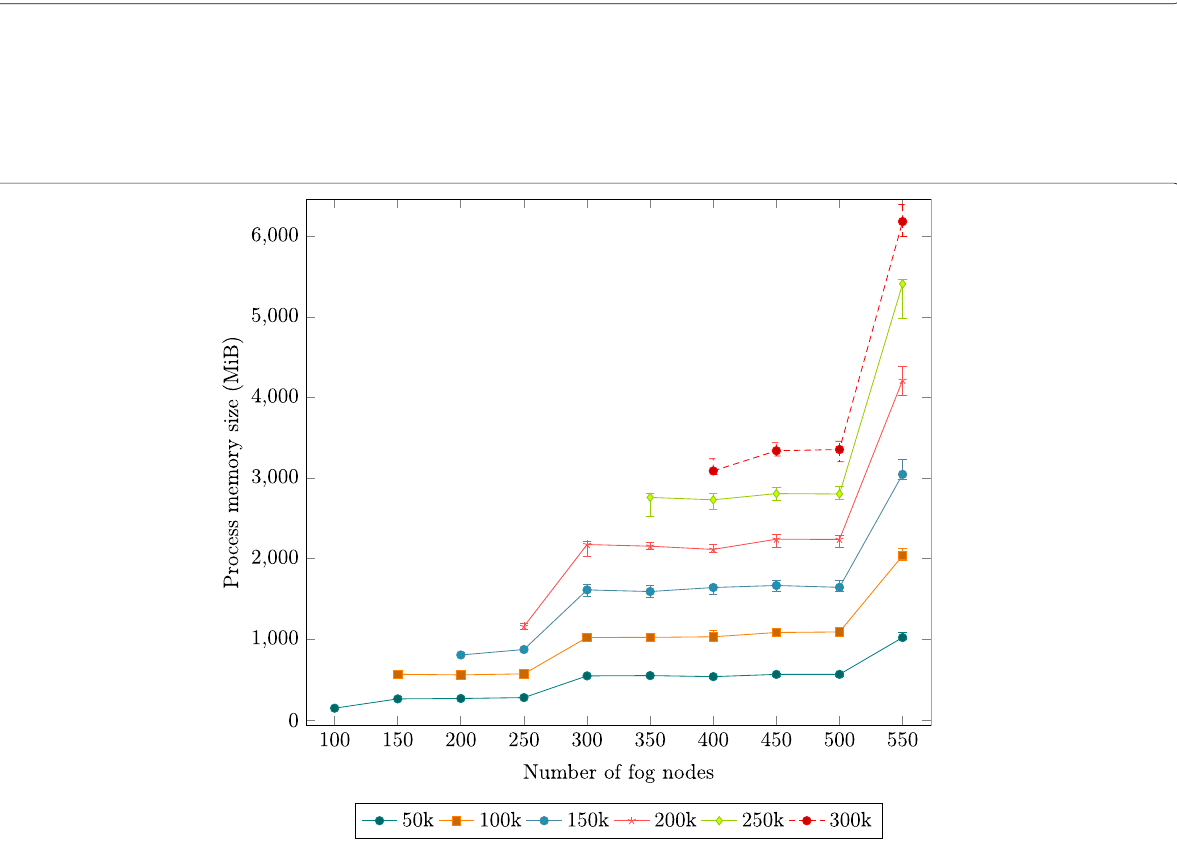
Fig. 7 Memory required for service topologies of varying sizes. Legend numbers represent thousands of edge